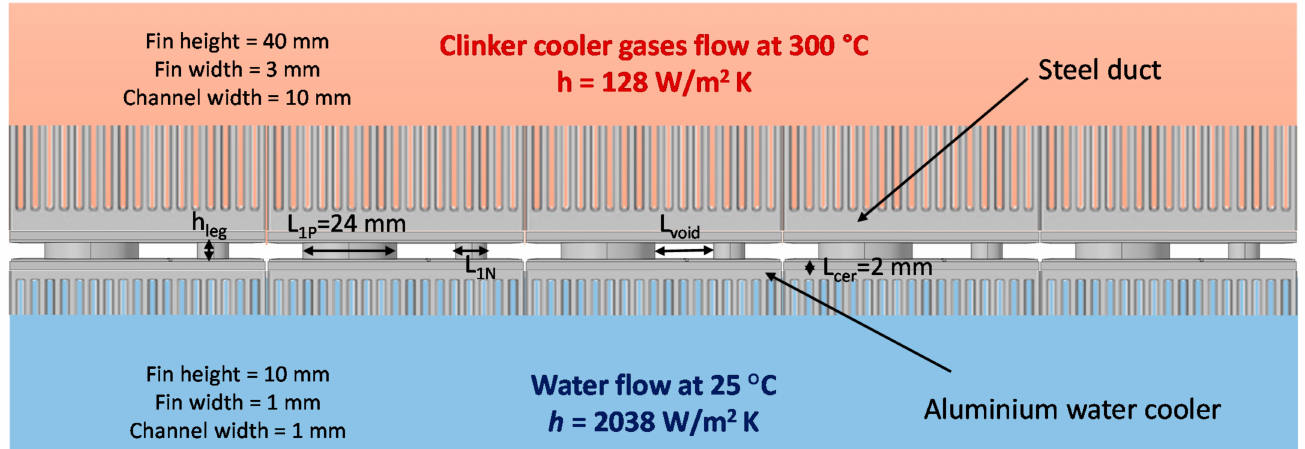
Figure 8. Simulation conditions for heat source/sink heat exchangers enhanced with finned